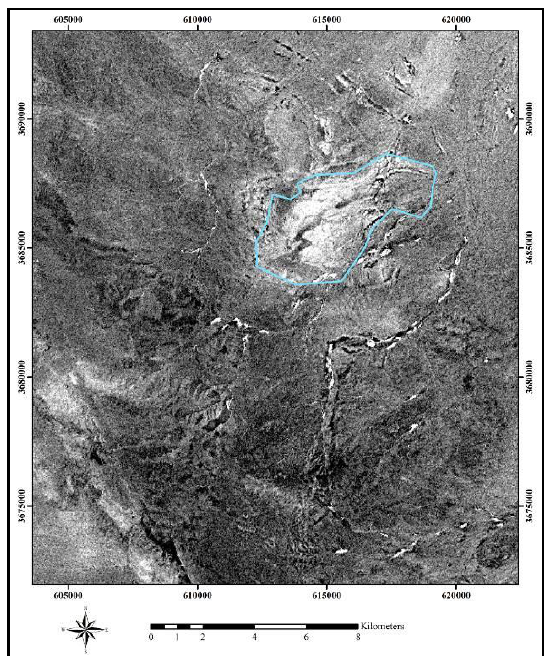
Figure 6. PC6 image for Ardestan scene; ellipsoidal polygons separate bright pixels as probable locations of epidote, calcite, and chlorite minerals.